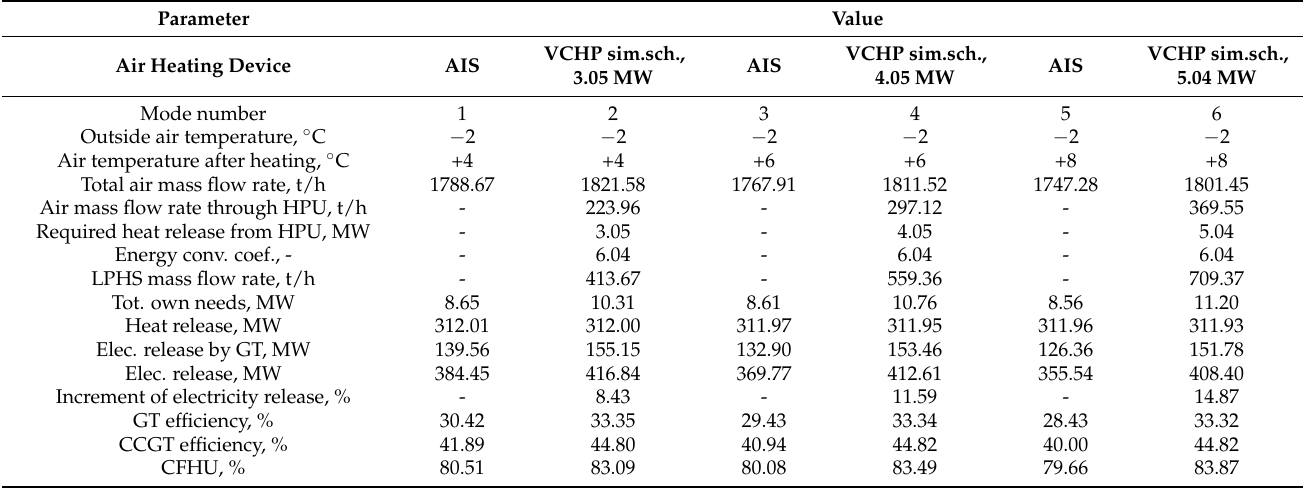
Table 9. Results of using VCHPs for heating the intake air for winter